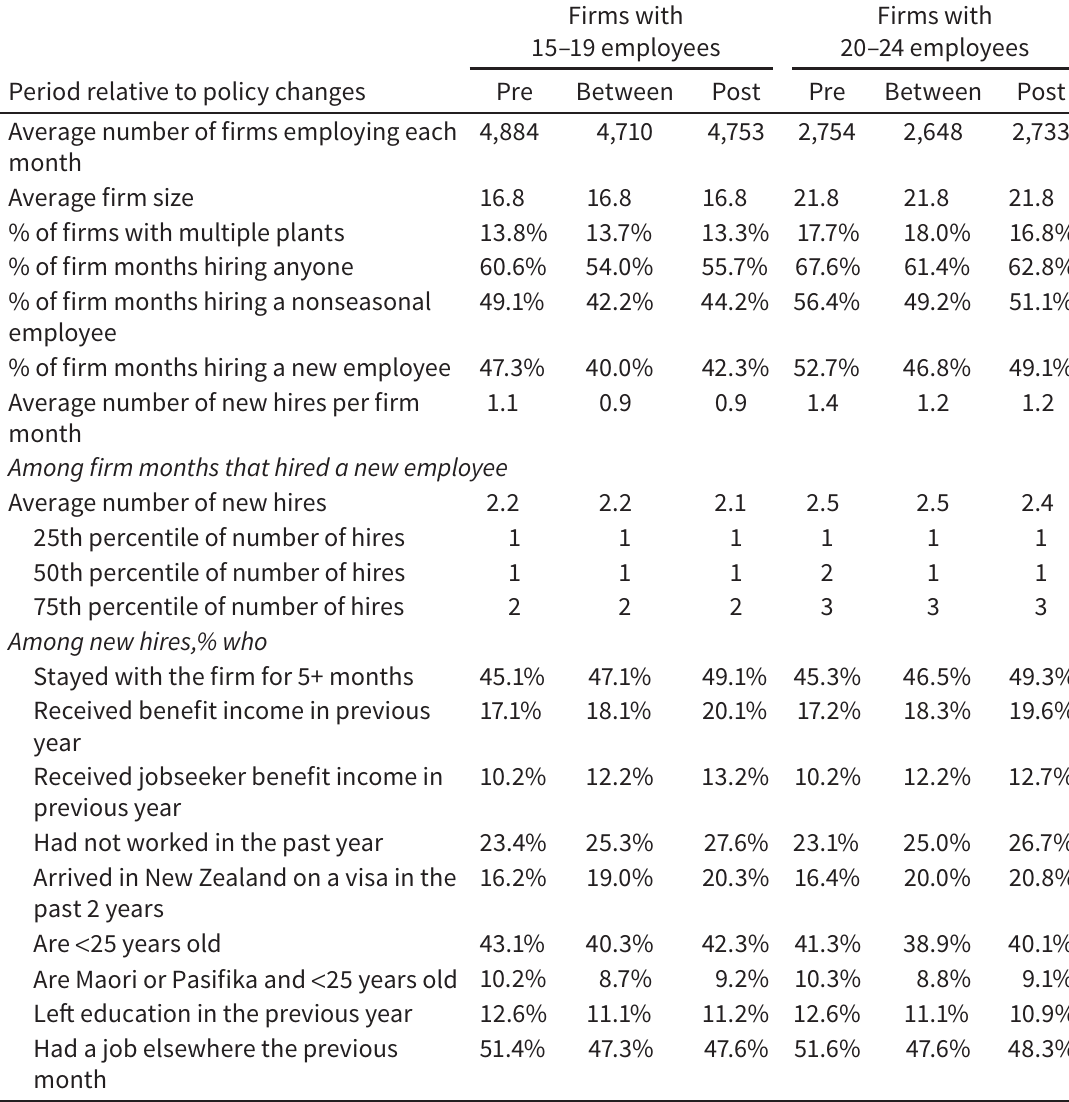
Descriptive statistics for treatment and control firms by